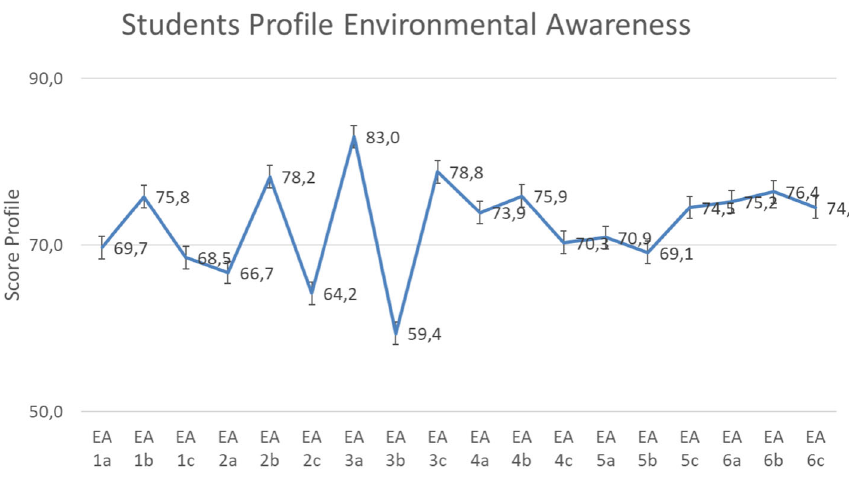
Figure 4. Environmental awareness sub-indicator profile.